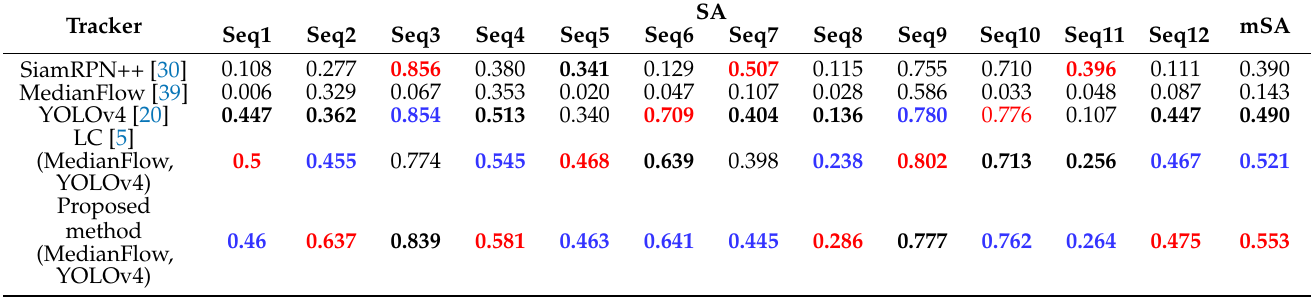
Table 3. Performance SA (%) and mSA (%) on test sequences (first-, second-, and third-ranked trackers are labeled in red, blue, and bold ,